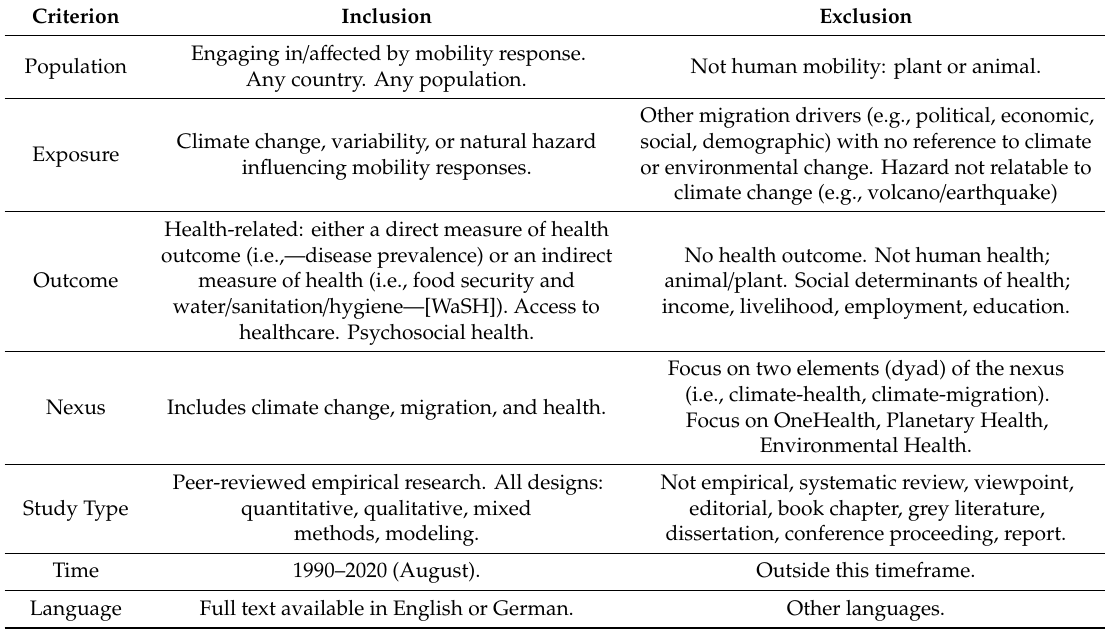
Table 2. Inclusion and Exclusion Criteria.